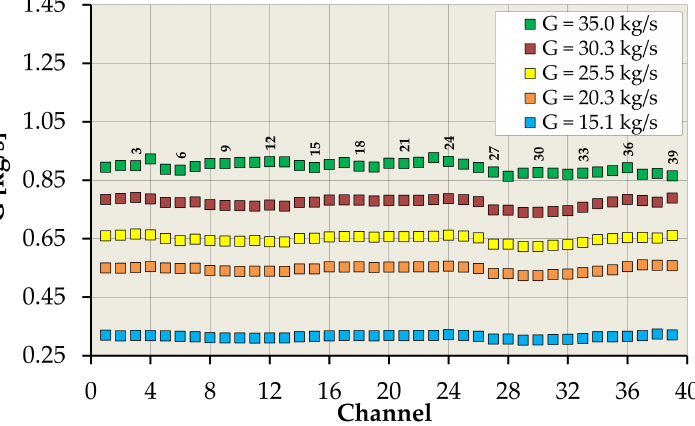
Figure 7. Ultrasonic flow meter measurements on 39 OVT plasma facing tubes at 70 ◦ C (raw data, passed to the numerical simulation